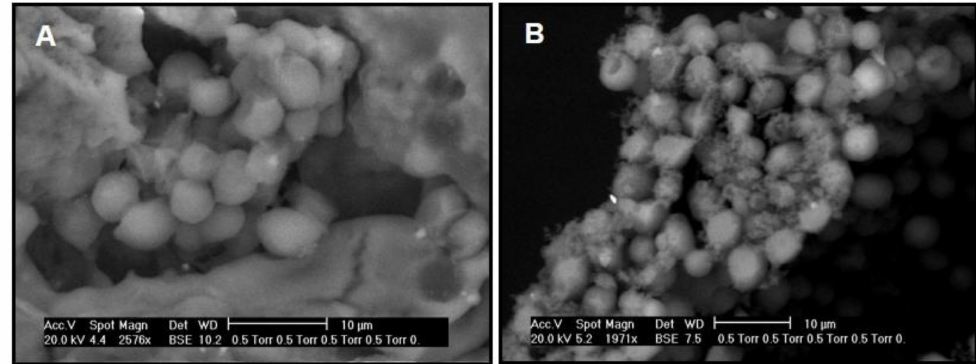
Figure 17. Environment scanning electron microscope (ESEM) of ale yeast strain damage: ( A ) Cells before passage through a disc centrifuge, and ( B ) cells following passage through a disc centrifuge operating at high G-force